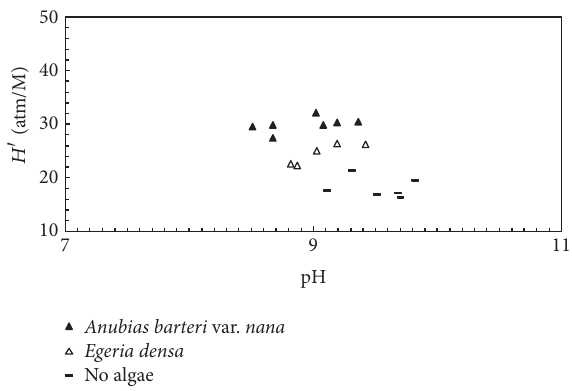
Figure 4: Variations of apparent Henry’s Law constants with pH (at 27 ∘ C) for adding different alkaline buffering materials.